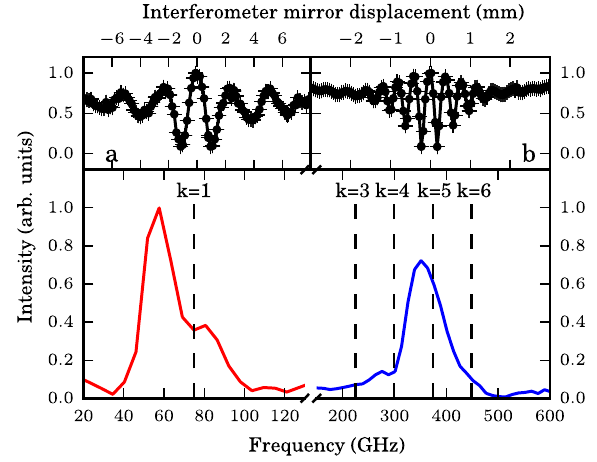
FIG. 4. TR spectral measurements results. a and b are interfero- grams measured in the range of 60 – 90 GHz and 320 – 460 GHz, respectively. Bottom plots: reconstructed spectra.